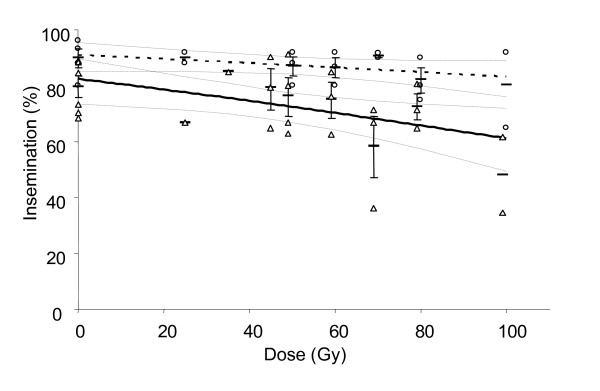
Insemination of virgin females mated with An. arabiensis males irradiated in pupal or adult stage for the different treatments. Triangles represent pupal individual values, circles adult individual values. Detransformed means (± SE if n>2) are indicated by a horizontal line. Linear regression lines (± 95% CI) are given; solid line is pupae, dotted line adults. For clarity purposes, data points for pupae have been shifted slightly to the left.